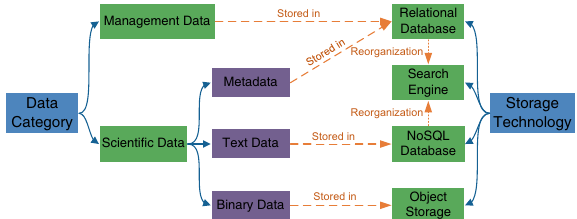
Fig. 3 An overview of data categories and storage technologies used in MGED and their relationships. The data stored in MGED are categorized as management data or scienti fi c data. The scienti fi c data are categorized as metadata, text data, or binary data. Each type of data is stored in the corresponding storage